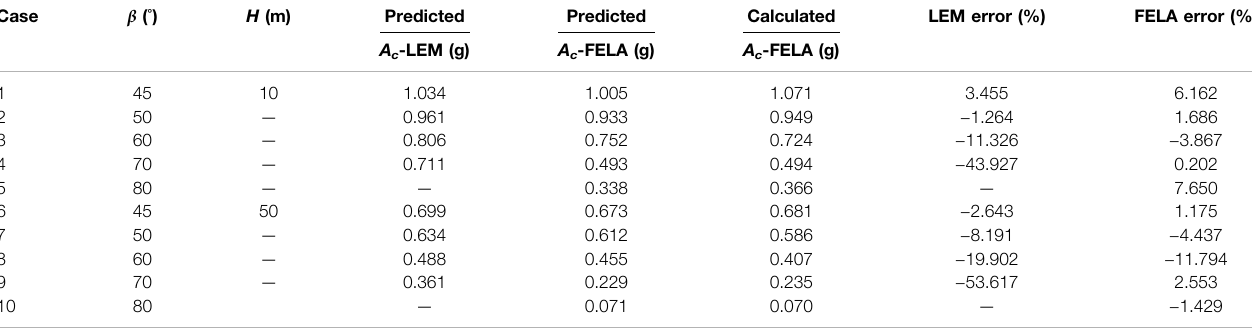
TABLE 5 | Comparison between the results of predicted A c and FELA simulation for different slope heights and slope angles (Note: GSI is 40, m i is 25, γ is 22 kN/m 3 , σ ci is 10 MPa). Case β ( ° )